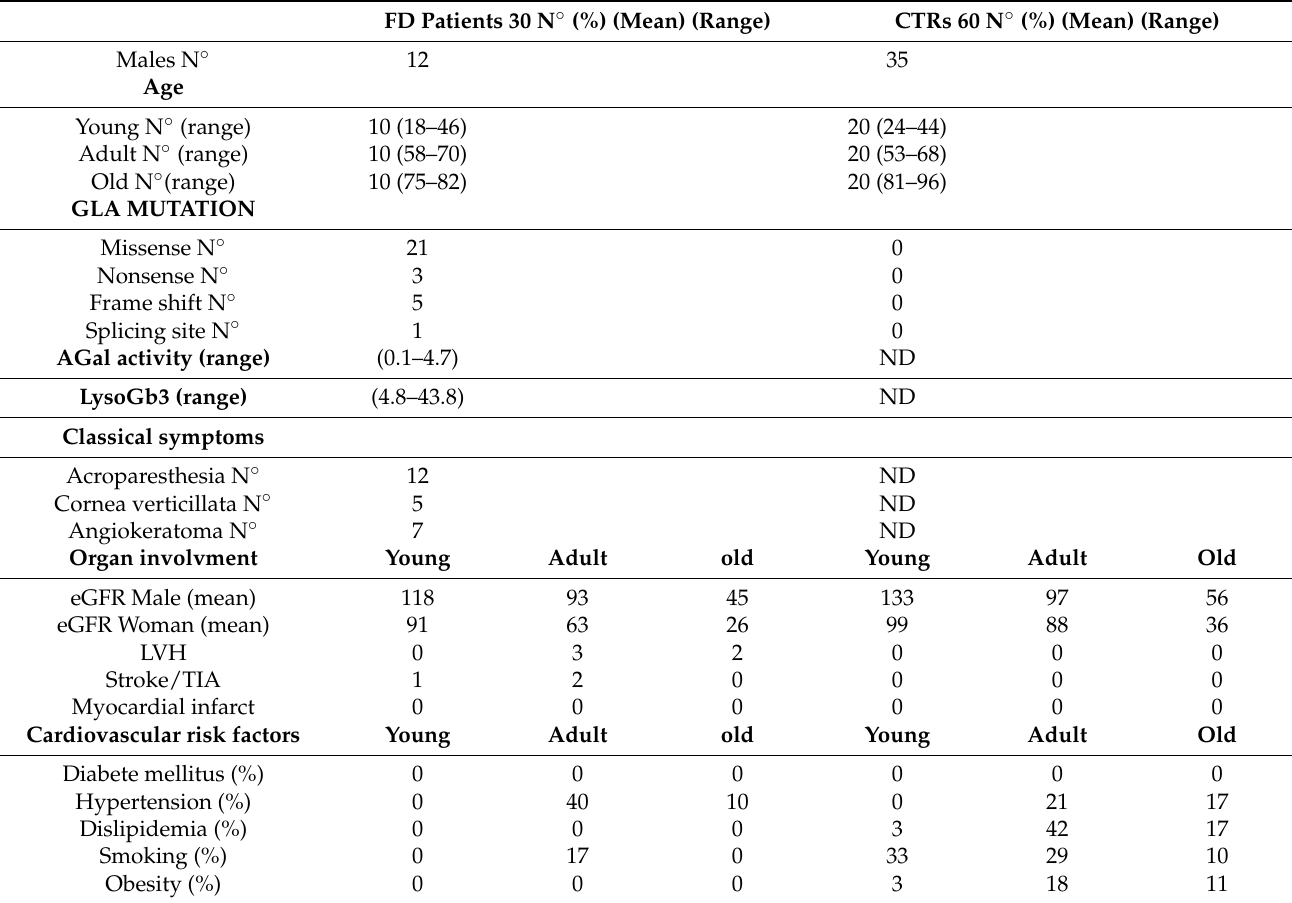
Table 1. Characteristics of Fabry Disease (FD) patients and controls